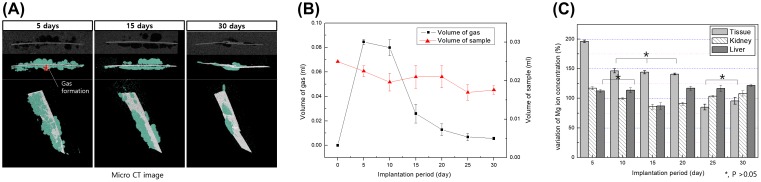
(A) Micro CT images of Mg plate (white color) and gas pocket (light blue) after implantation in rats for 5, 15 and 30 days, (B) Volume of the Mg plate and gas pocket after implantation in rats for 30 days, and (C) Mg ion concentration in muscle tissue attached to the specimen, kidney and liver measured by ICP-MS.